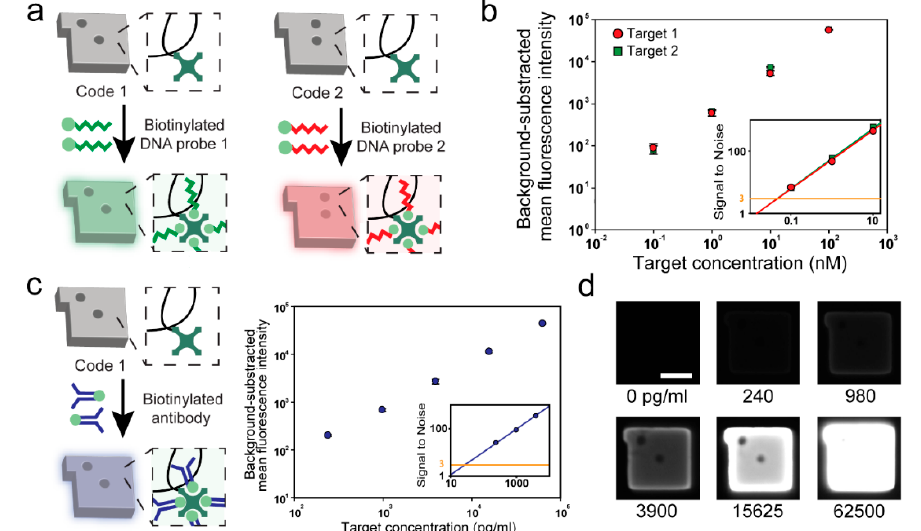
Figure 3. Assay performance and flexibility evaluation of streptavidin-conjugated encoded hydrogel microparticles. ( a ) Schematic view of the process used for the attachment of the biotinylated DNA probe to hydrogel microparticles. ( b ) Standard calibration curves of two DNA targets. ( c ) Schematic view of the process used for the attachment of biotinylated antibodies to hydrogel microparticles (left) and standard calibration curves for ovalbumin (right). ( d ) Monochrome micrograph of the particles at various ovalbumin concentrations. Scale bar represents 25 μ m.